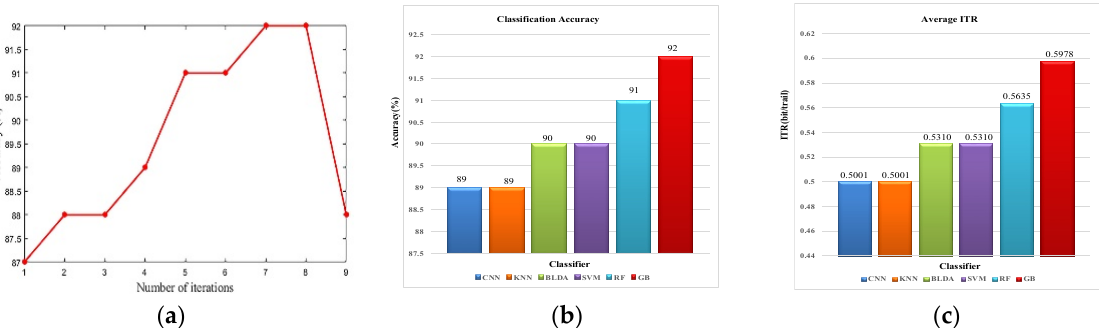
Figure 7. ( a ) The classification curve versus the number of iterations. ( b ) The classification accuracy of deep representation combined with CNN, KNN, BLDA, SVM, RF, and GB classifiers, respectively. ( c ) The average ITR of each trial.